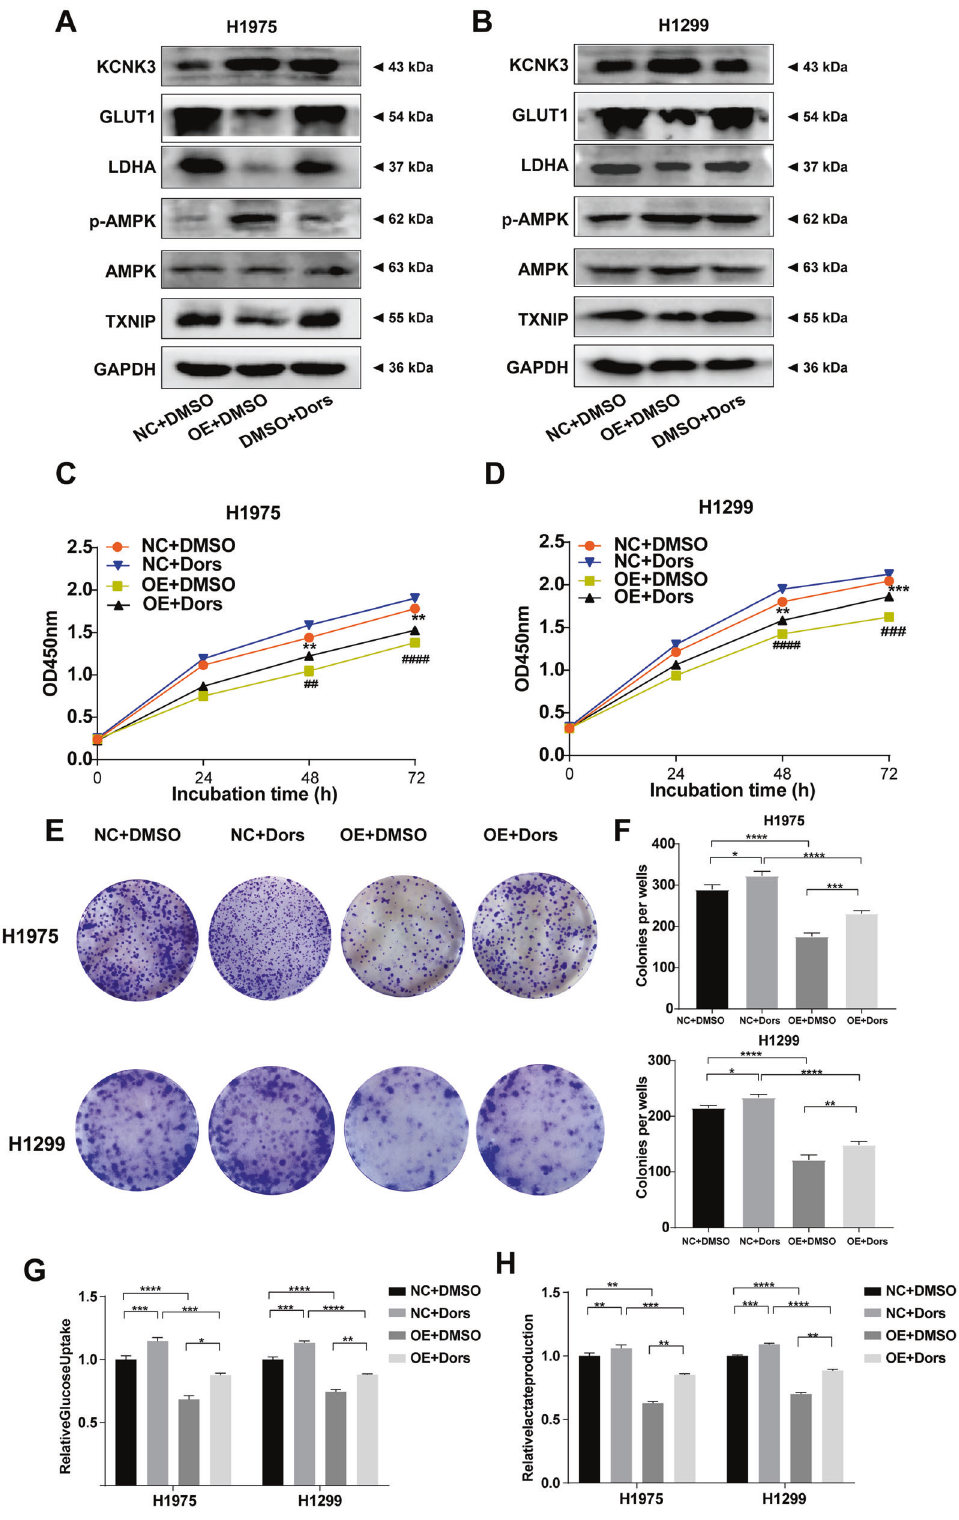
Fig. 6 KCNK3 inhibited proliferation and glucose metabolism via activation of the AMPK-TXNIP pathway in LUAD cells. A , B The expression of KCNK3, GLUT1, LDHA, p-AMPK, AMPK, TXNIP was detected by western blot in LUAD cells after administration with AMPK inhibitor (Dors, Dorsomorphin), with results normalized relative to the expression of GAPDH. C , D The proliferative curves of LUAD cells were detected by CCK-8 assay and expressed as OD values. E , F Clone formation assays were performed to evaluate the proliferation of KCNK3 overexpression LUAD cells after treating with AMPK inhibitor. G , H Relative glucose uptake and lactate production were measured in KCNK3- overexpressed or control LUAD cells after AMPK inhibitor treatment. (Data are presented as the mean ± SD of three independent experiments. * P < 0.05, ** P < 0.01, *** P < 0.001, **** P < 0.0001; ## P < 0.01, ### P < 0.001, #### P < 0.0001).